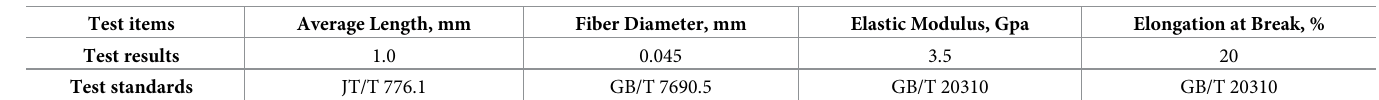
Table 5. Technical properties of lignin fiber.